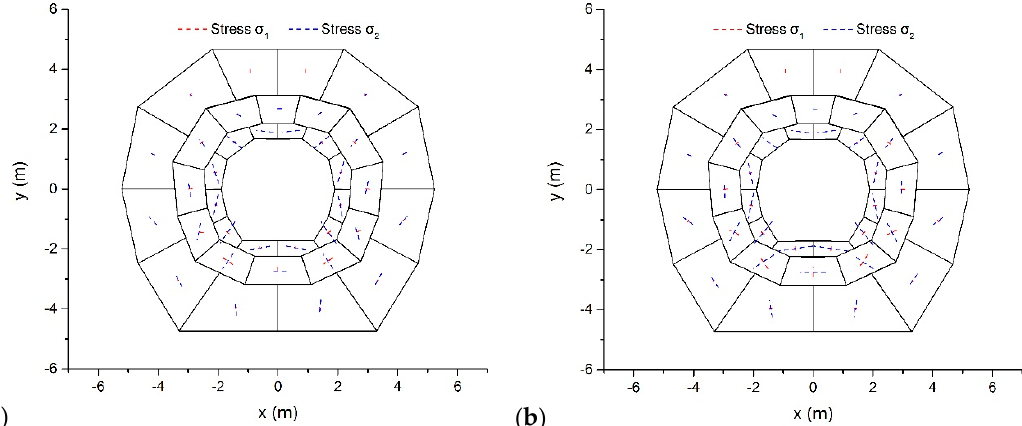
Figure 10. Configurations and main stresses after 100 time steps under two different friction angles: ( a ) φ = 30° and ( b ) φ = 0°.